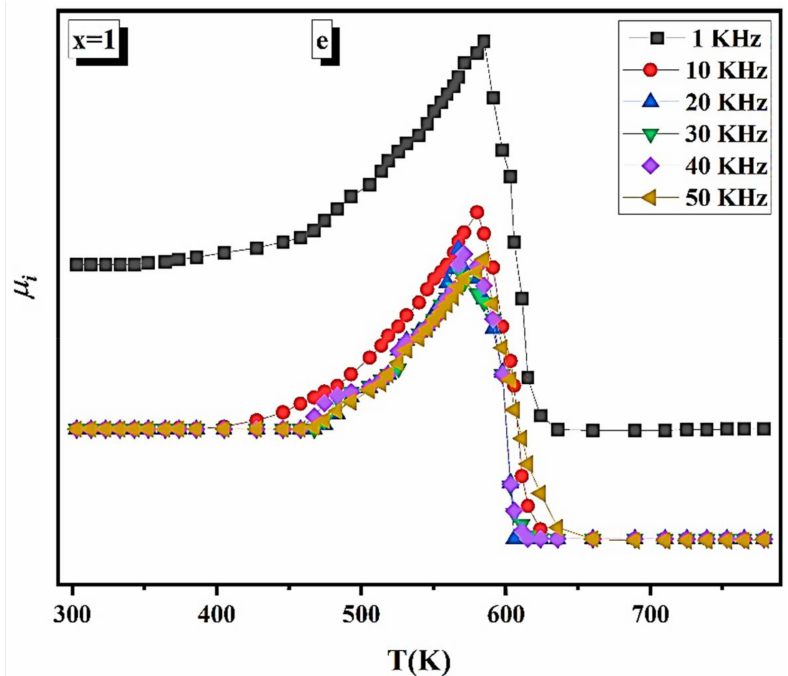
Figure 10. ( a ) µ i as a function of temperature at different frequencies of Ni + 2 ( b ) µ i as a function of temperature at different frequencies of Ni + 2 as a function of temperature at different frequencies of Ni + 2 function of temperature at different frequencies of Ni + 2